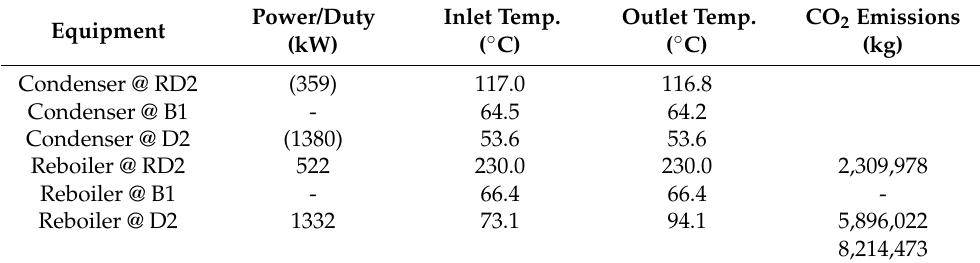
Table 6. Hot and cold stream data for the optimized intensified process for PGMEA